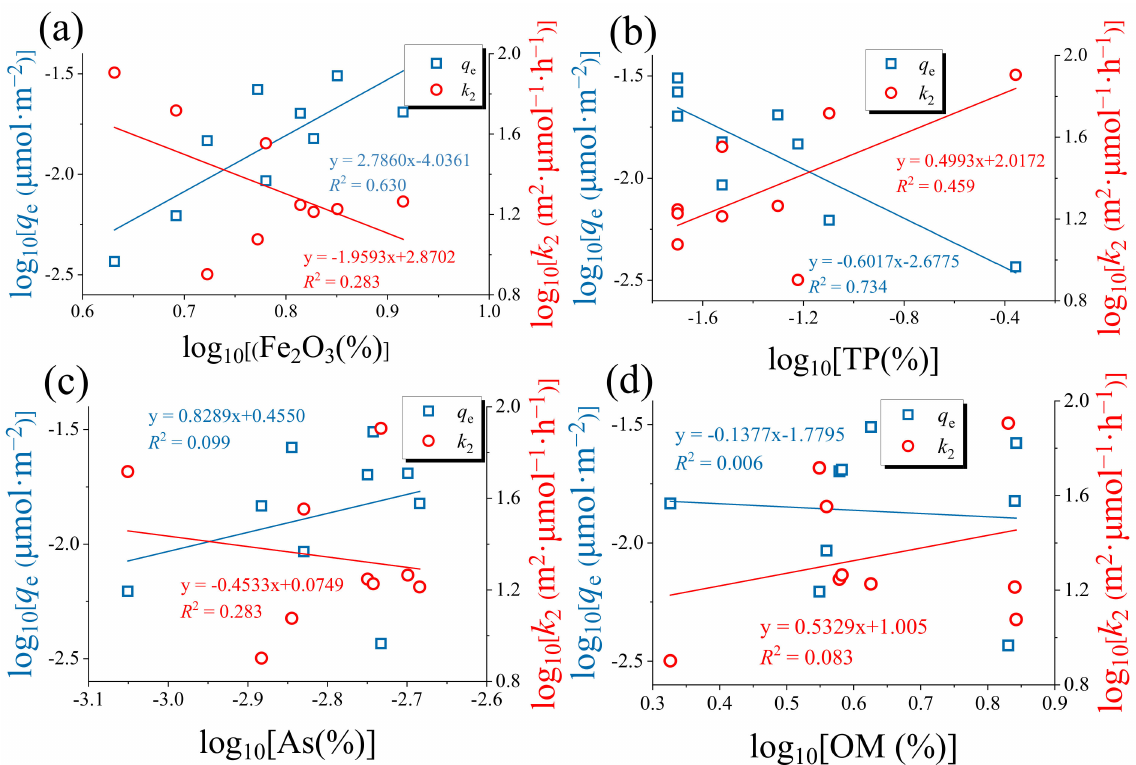
Figure 7. Correlation fitting between ASA adsorption amount ( q e ) and ( a ) Fe 2 O 3 content, ( b ) TP content, ( c ) As content, and ( d ) OM